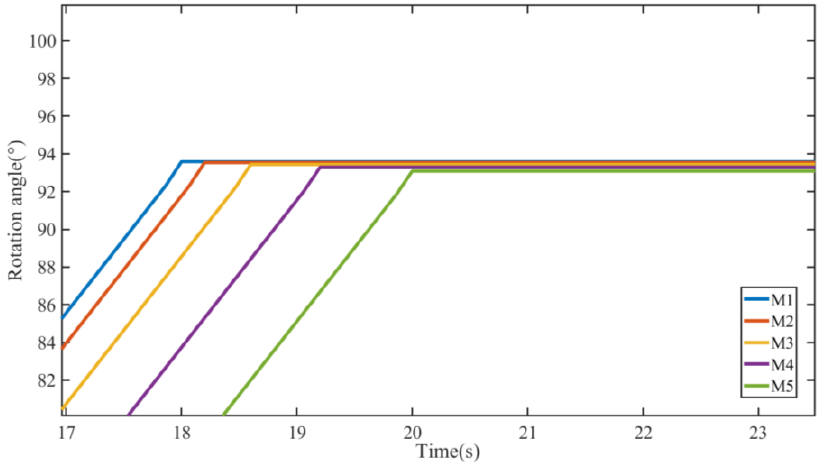
Figure 18. The rotation angle of leakage in hydraulic motor.